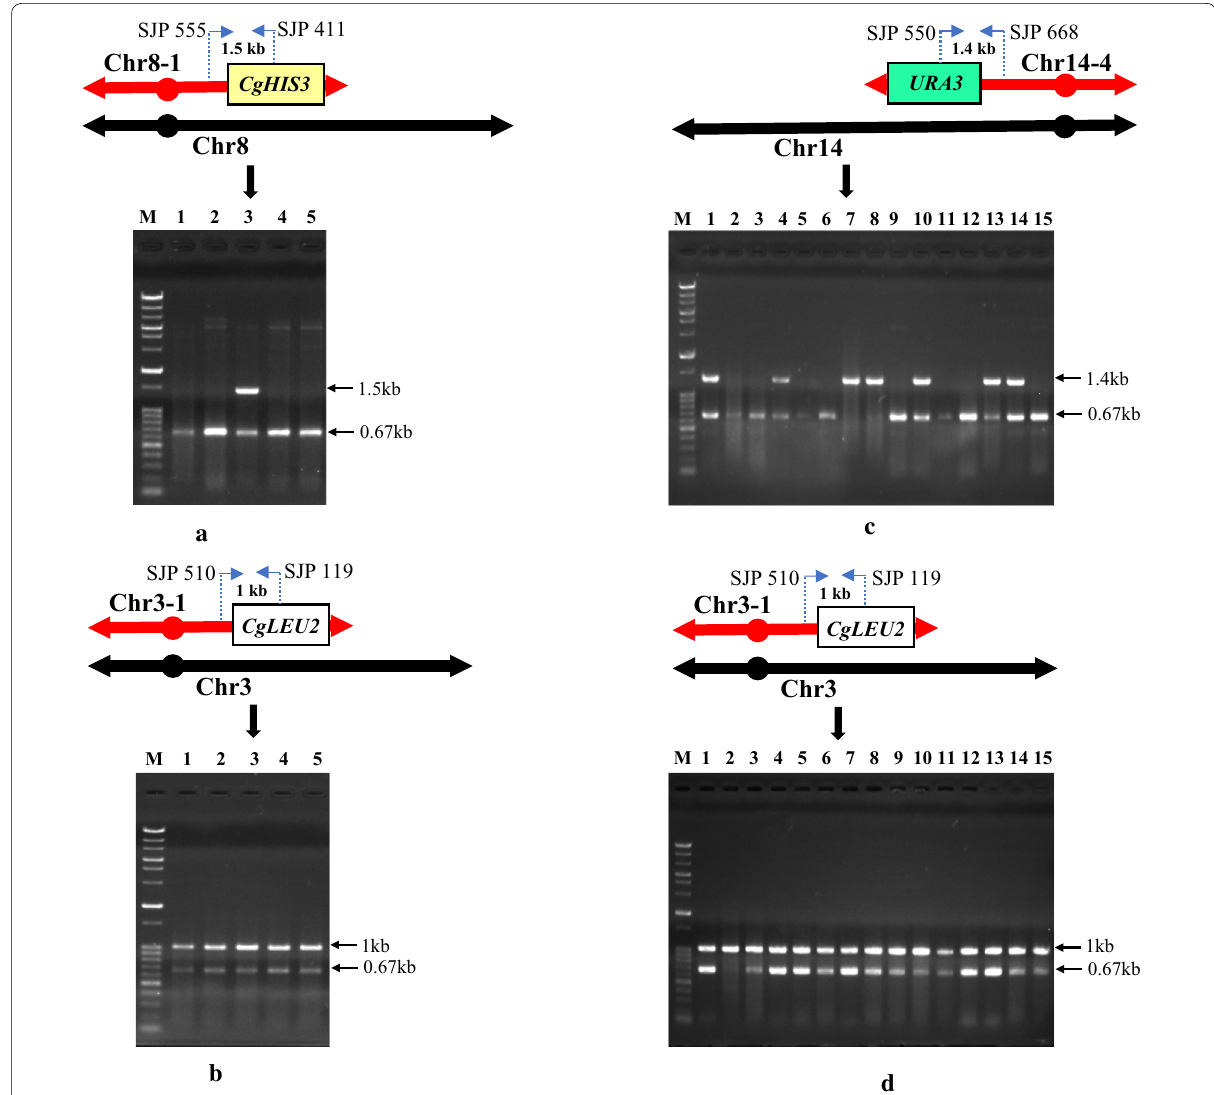
Fig. 4 Colony PCR analysis of Chr3-1 and Chr8-1 as well as Chr3-1 and Chr14-4 sequentially duplicated transformants. In the colony PCR, each lane represents independent transformants. Fig. 4 a , b represents the sequential duplication of the Chr3-1 and Chr8-1 regions, respectively. In Fig. 4 a , primers SJP 555 and SJP 411 were used to amplify the 1.5 kb band from the duplicated Chr8-1 region and in Fig. 4b, primers SJP 510 and SJP 119 were used to amplify the 1 kb band from the duplicated Chr3-1 region. Fig. 4 c , d represents the sequential duplication of the Chr3-1 and Chr14-4 regions, respectively. In Fig. 4 c , primers SJP 550 and SJP 668 were used to amplify the 1.4 kb band from the duplicated Chr14-4 region and in Fig. 4 d , primers SJP 510 and SJP 119 were used to amplify the 1 kb band from the duplicated Chr3-1 region. In all PCR analysis the 0.67kb CNE1 gene on Chromosome 1 was also amplified as an internal control by a common set of primers SJP 121 and SJP